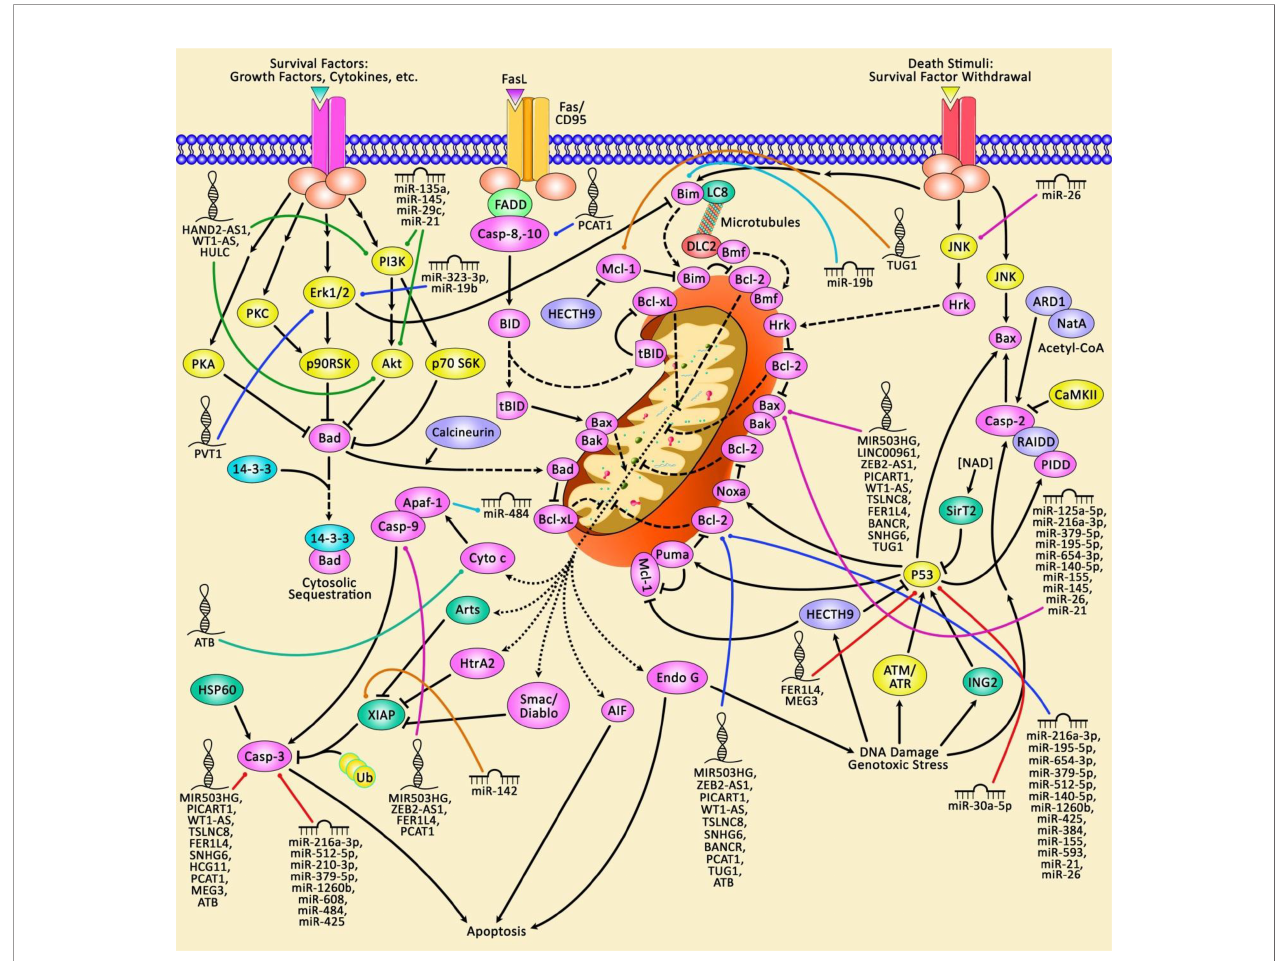
FIGURE 1 | A schematic representation of the role of non-coding RNAs in triggering the mitochondrial pathway of apoptosis in human lung cancer. The Bcl-2 family of proteins could play an effective role in modulating apoptosis via regulating mitochondrial cascade. The anti-apoptotic proteins Bcl-2 and Bcl-xL are located in the exterior part of mitochondrial wall and can suppress cytochrome c release. The pro-apoptotic Bcl-2 proteins Bax, Bad, Bim, and Bid could be located in the cytosol but may be transferred to mitochondria following induction of death signaling pathway, where they could elevate the release of cytochrome c (8, 9). The mitochondrial cascade of apoptosis could be considered as the most commonly deregulated form of cell death in a variety of human cancers. Furthermore, aberrant expression of various non-coding RNAs could have a crucial part in dysregulating the mitochondrial pathway of apoptosis in lung